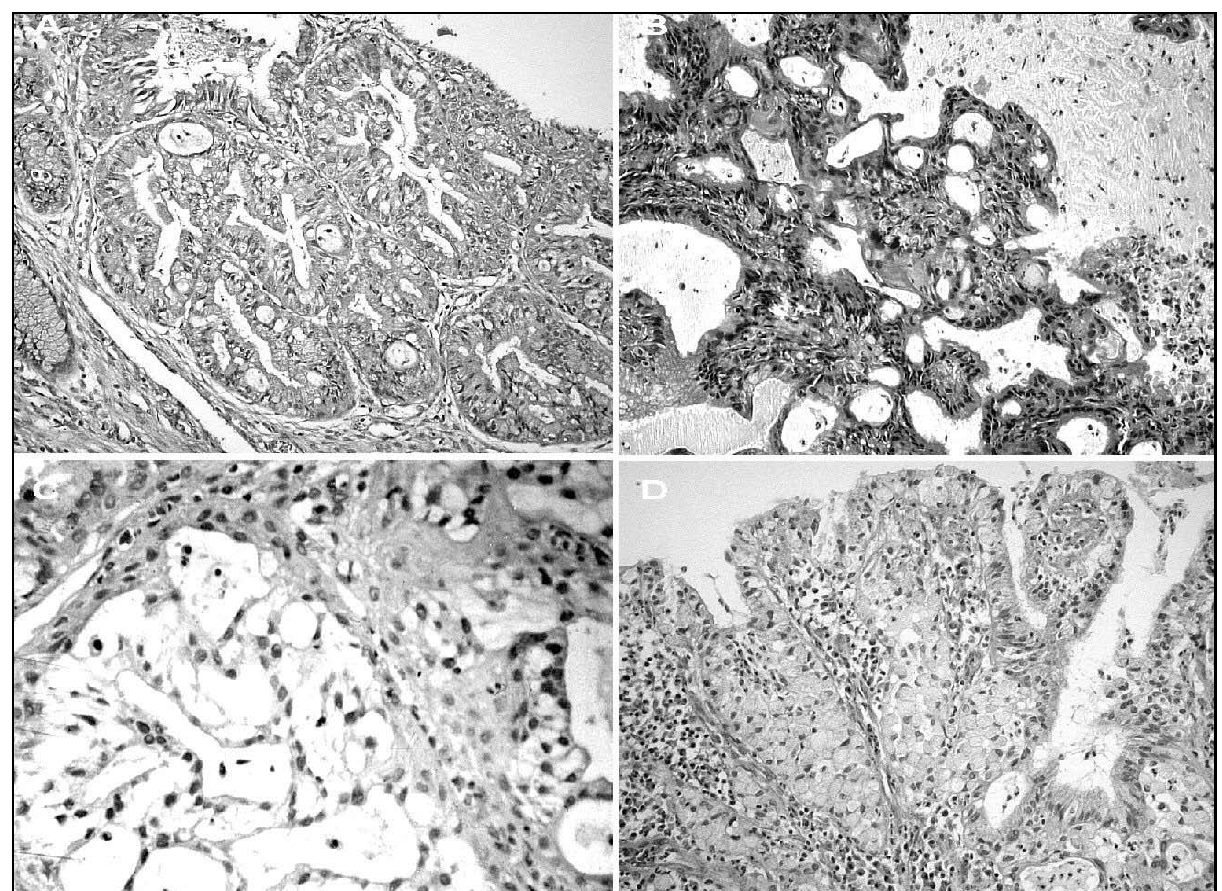
Figure – Microglandular hyperplasia (MGH) histological patterns. A: glandular type (the most common); B: trabecular; C: reticular; D: